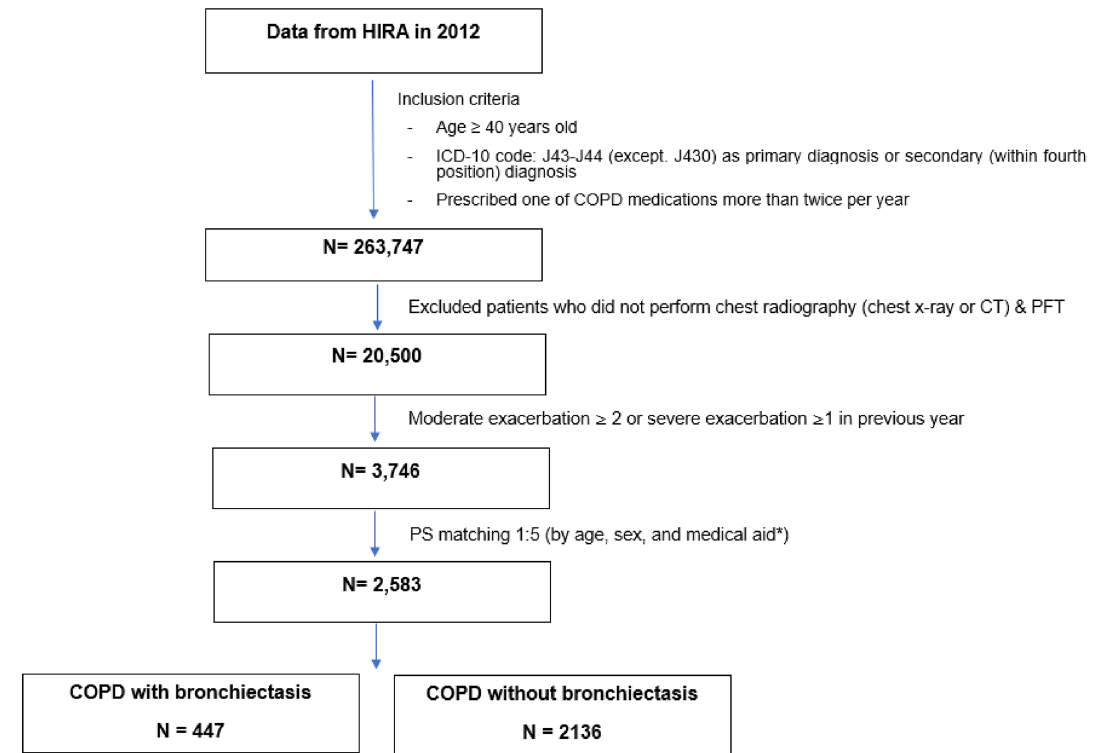
Figure 1. Flowchart of the study populations. *Patients with low socioeconomic status were covered with medical aid in